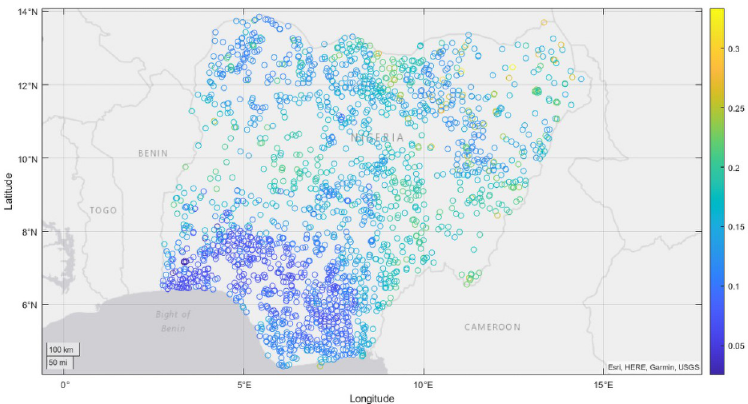
Fig 3. Uncertainty in asset poverty prevalence for Nigeria, 2013. Uncertainty is measured as the standard deviation of asset poverty prevalence prediction across each tree in our MRF.